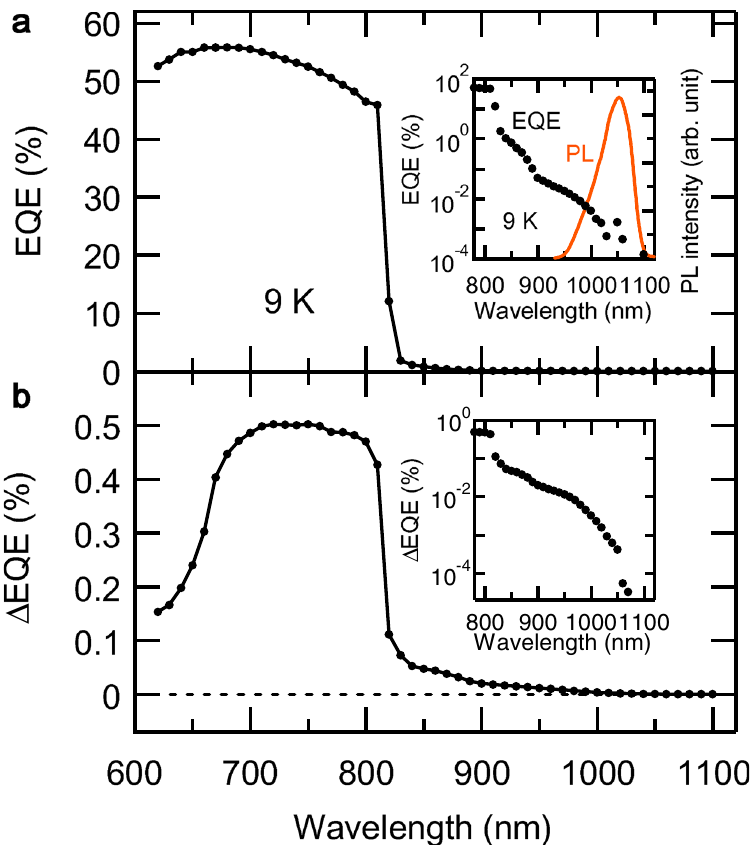
Figure 1. EQE and Δ EQE spectra for QDSL-IBSC. ( a ) EQE spectrum measured at 9 K. ( b ) Δ EQE spectrum measured at 9 K. The inserts show magnified plots in the subbandgap region. PL spectrum was measured for the interband excitation of 800